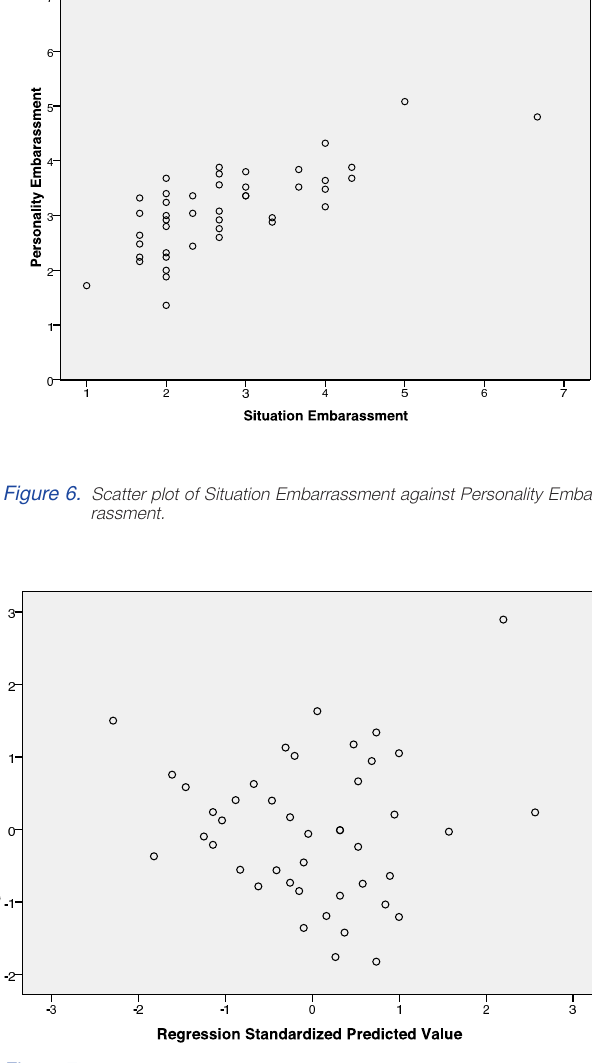
Figure 7. Regression standardized